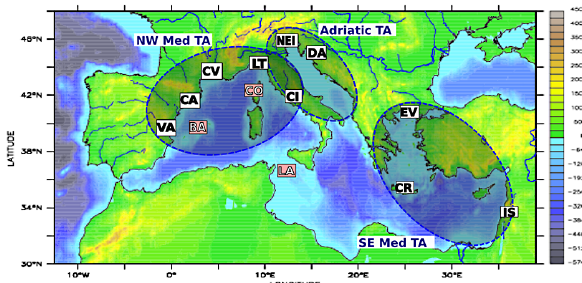
Figure 1. HyMeX target areas (TA) in the Mediterranean basin and hydro-meteorological sites. Liguria–Tuscany (LT), northeast- ern Italy (NEI) and central Italy (CI) are located within the Italian territory. After Ducrocq et al.,2010